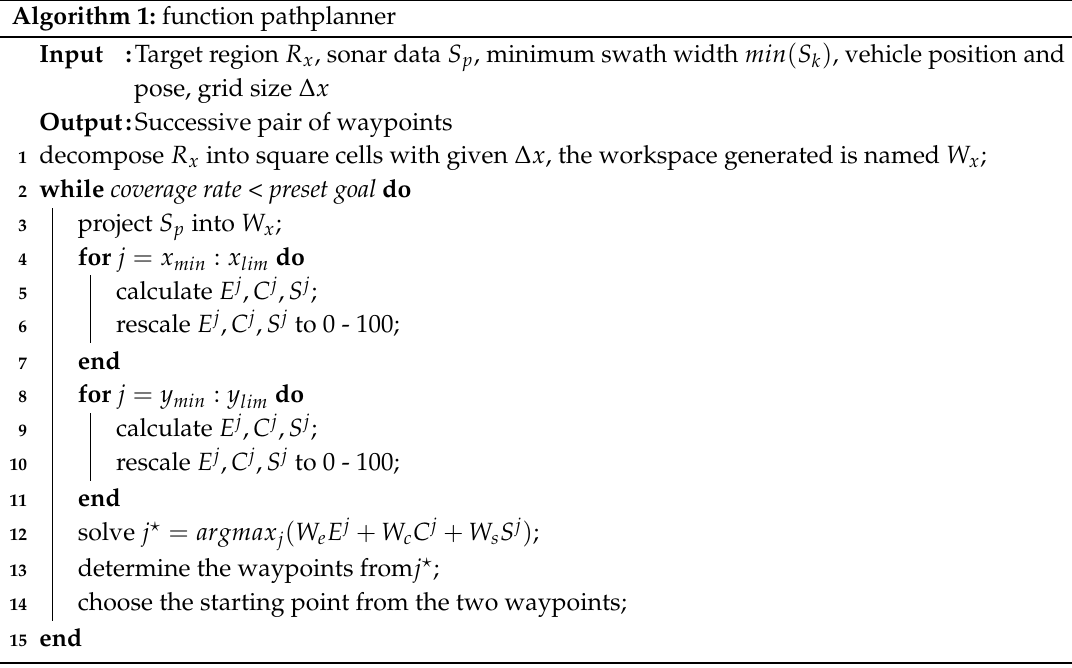
Algorithm 1: function